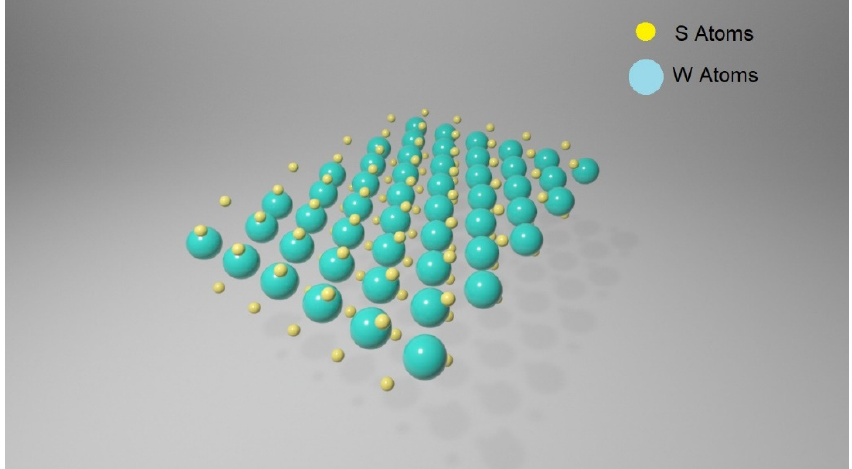
Figure 3. Schematic of a WS 2 monolayer: plane consisting of W atoms (in green) and S plane (in yellow).